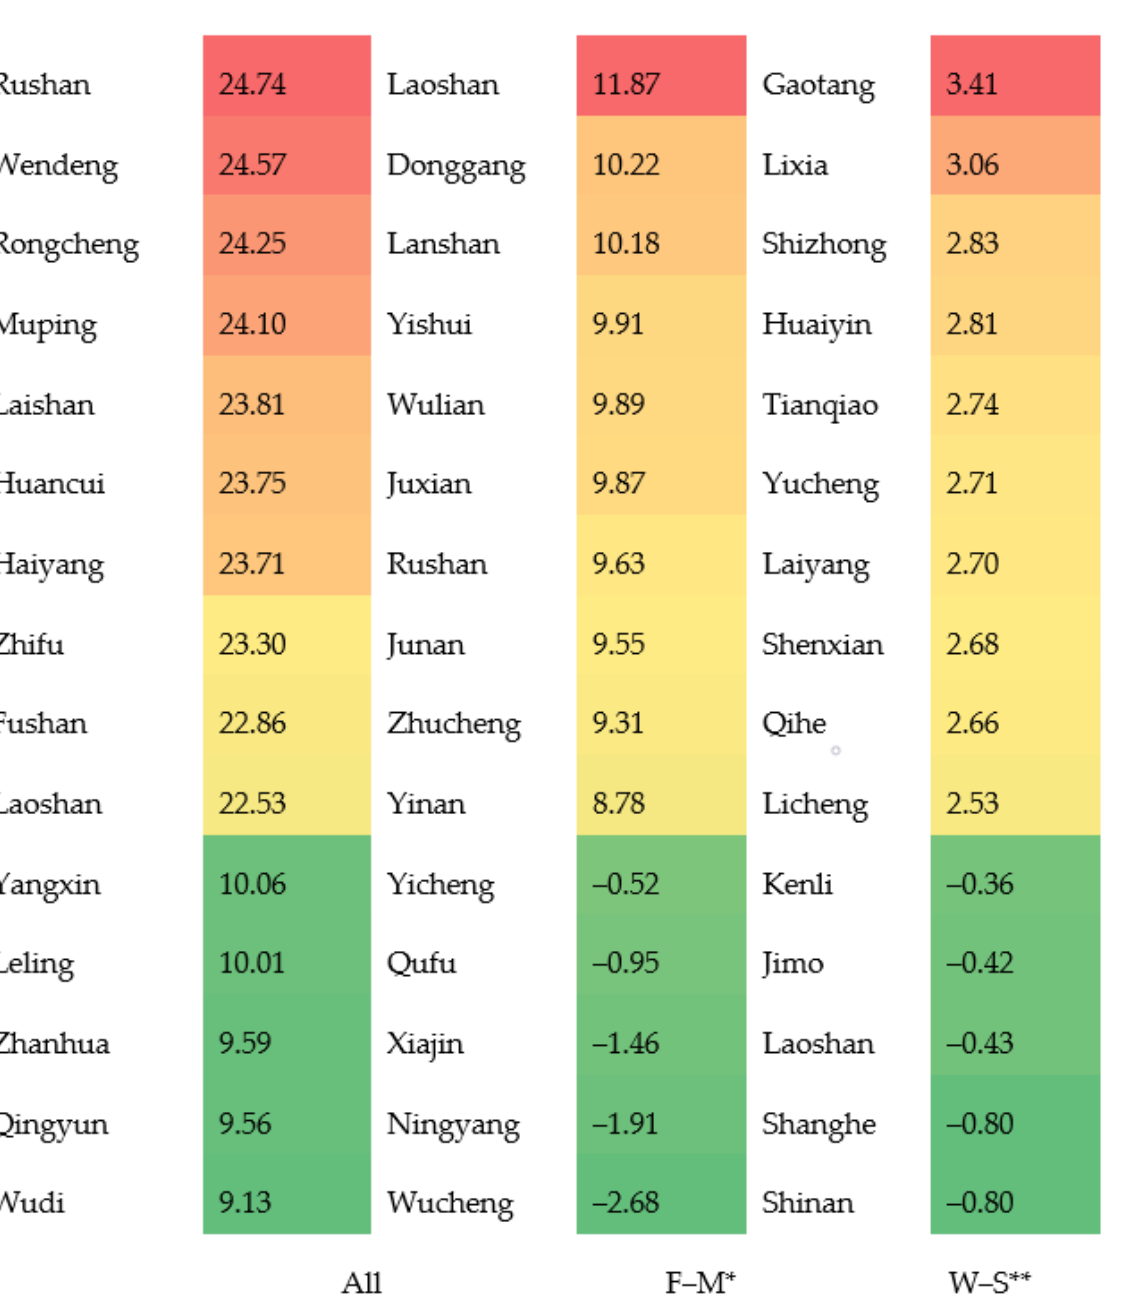
Figure 4. Rank of counties by estimated mortality of diabetes (top 10 and lowest 5) in Shandong Province, China, 2014; F − M*: rates in women minus rates in men; W − S**: difference between mortality in winter and mortality in summer (calculated as the mortality in winter minus mortality in